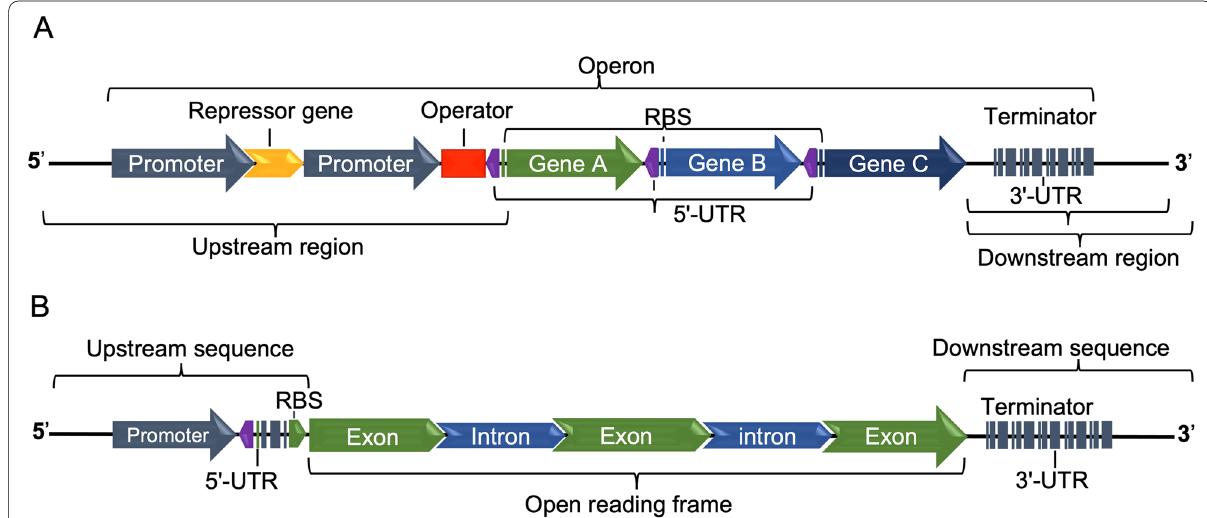
Fig. 1 Structure of prokaryotic and eukaryotic genes. A and B show the elements that comprise the canonical genes. A In prokaryotic genes, the regulatory gene elements for transcription are sited upstream, downstream, and on regulatory sequences such as RBS and intergenic UTRs. B In eukaryotic genes, the regulatory gene elements for transcription are sited upstream, downstream, and intronic regions. 5 ′ ‑UTR: 5 ′ ‑untranslated region, 3 ′ ‑UTR: 3 ′ ‑untranslated region, RBS: ribosome binding